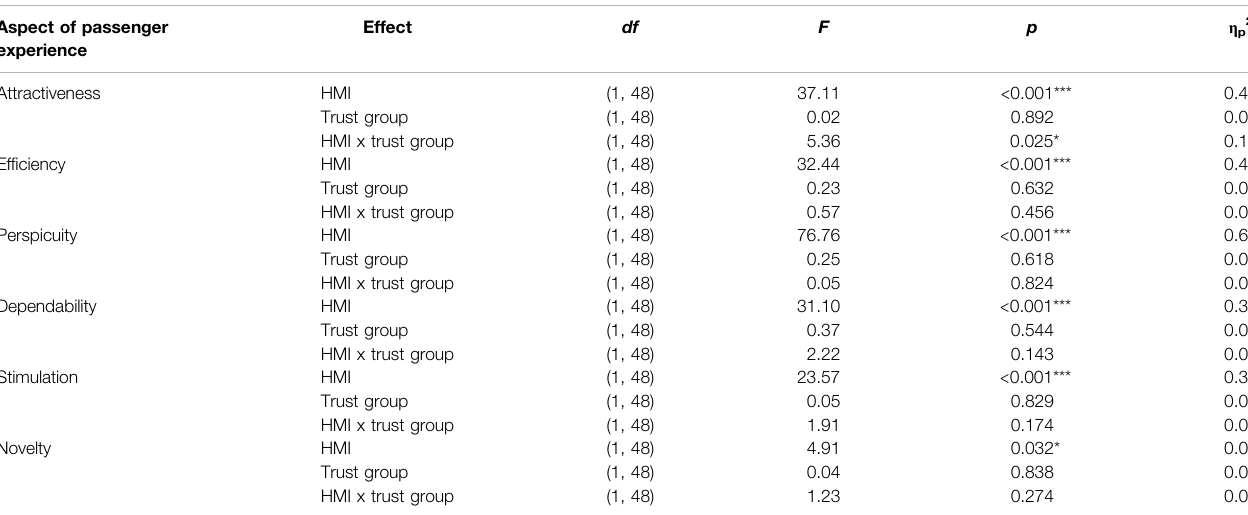
TABLE 5 | Mixed design ANOVA results on the effects of HMI version and trust group membership on HMI-Related user experience. Aspect of passenger experience